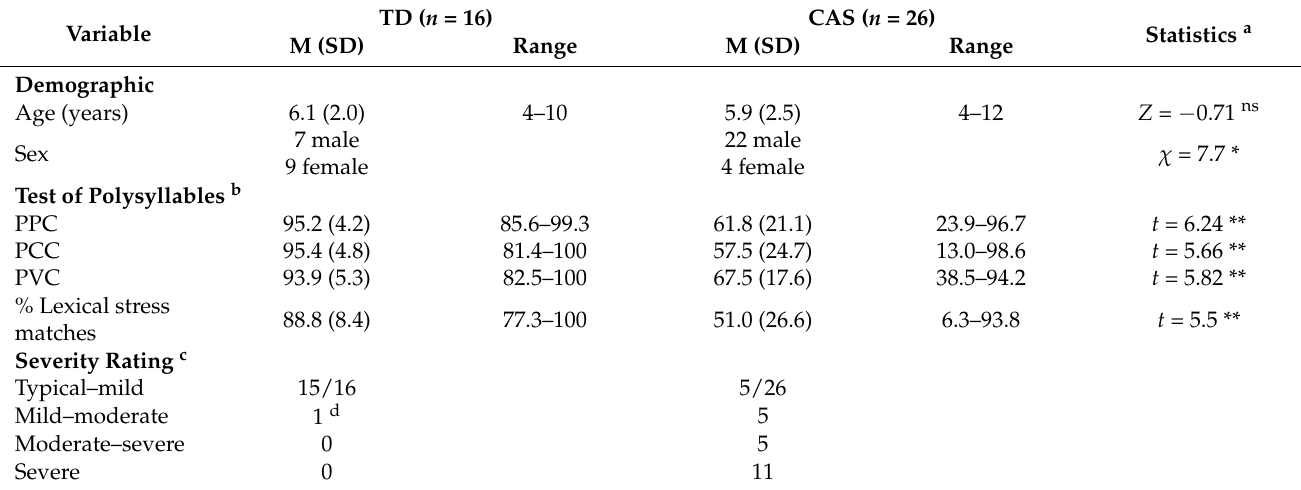
Table 1. Participant demographic and diagnostic speech production